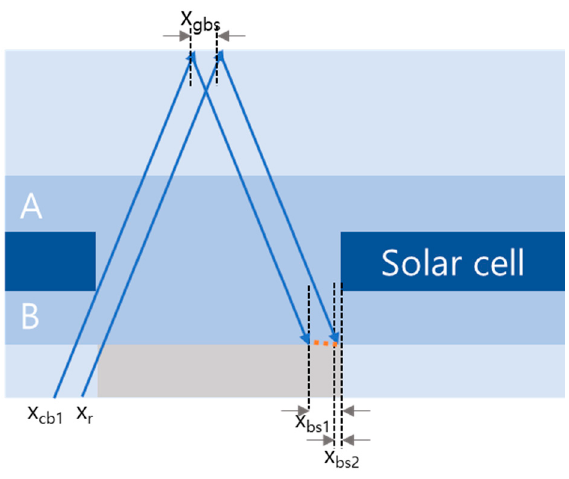
Figure 8. Illuminated area depending on back surface irradiance.